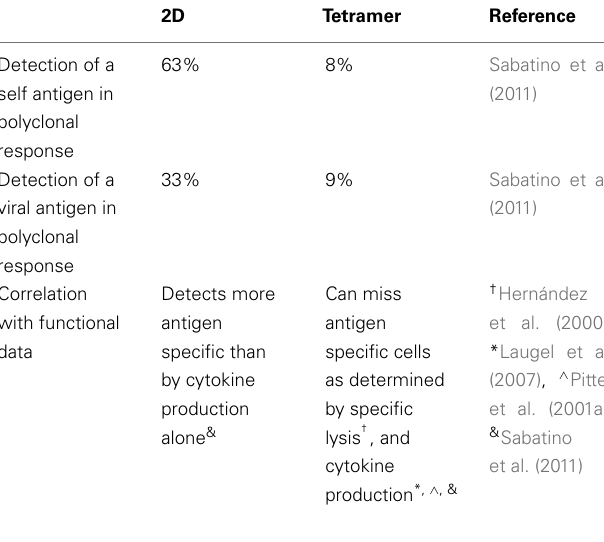
Table 2 | Comparison between 2D and tetramer identification